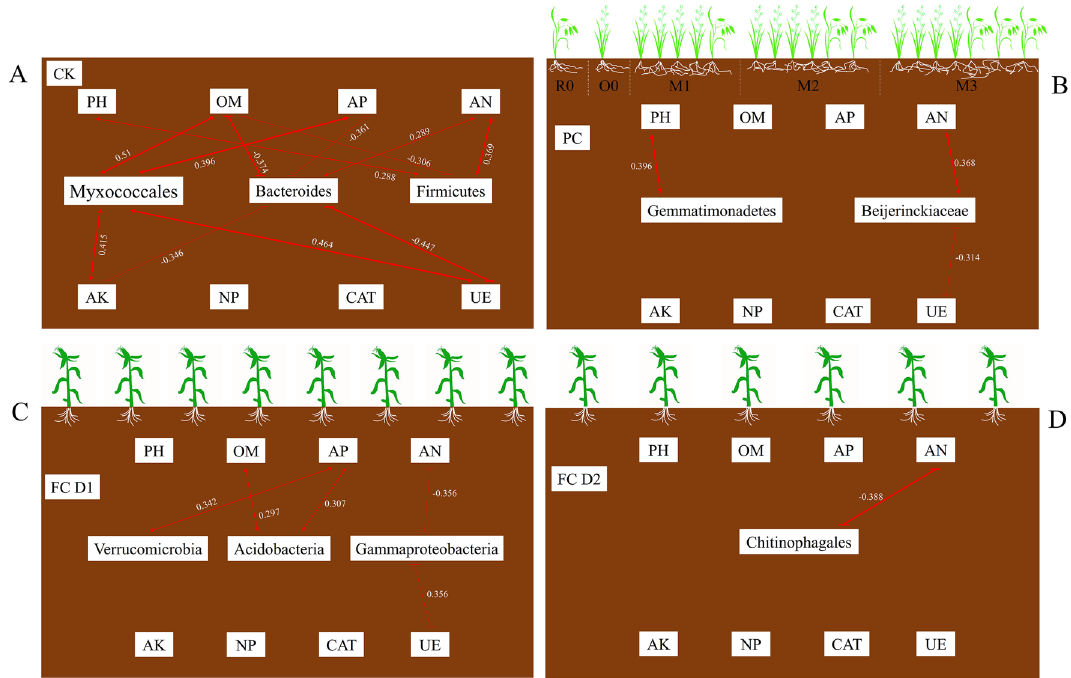
Figure 7. Spearman analysis showing the correlation between soil bacteria biomarkers and soil physicochemical properties or enzyme activity in CK ( A ), Preceding crop ( B ), SC·D1 ( C ), and SC·D2 ( D ). The numbers express the correlation coefficient. The red arrows indicate p values < 0.05 and the bold red arrows indicate p values < 0.01. PH: potential of hydrogen; OM, organic matter content; AN, available nitrogen; AP, available phosphorus; AK, available potassium; NP, neutral phosphatase activity; CAT, catalase activity; UE, urease activity. The lines end in arrows indicated the positive correction and lines end in horizontal line indicated the negative